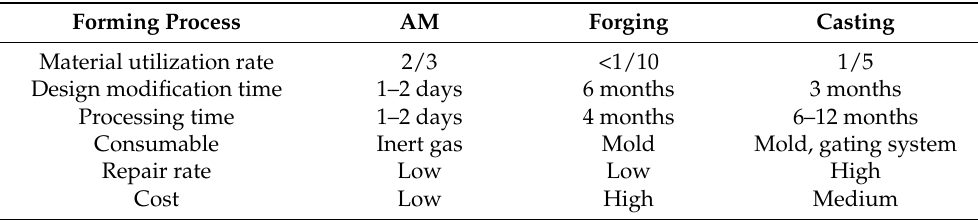
Table 2. A comparison of AM and the conventional manufacturing methods for complex structural components [24].